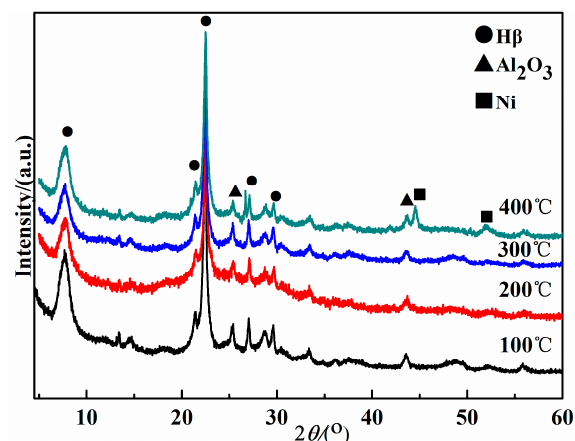
Figure 3. XRD patterns of NiP/H β calcined at different temperatures.